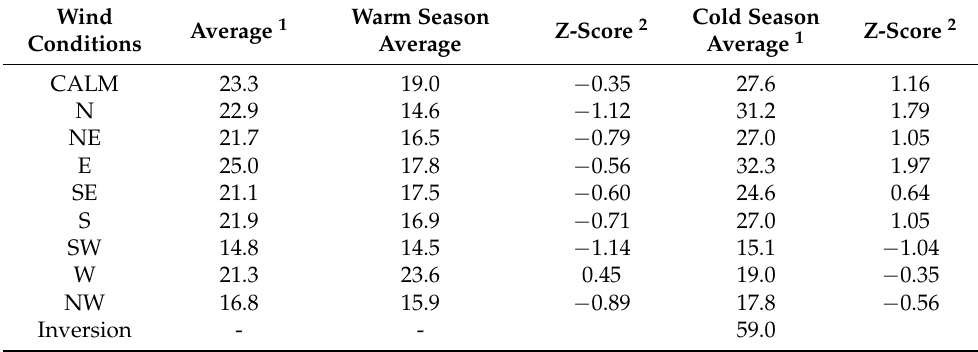
Table 1. Average PM 10 concentrations for the observed period ( µ g · m − 3 ).